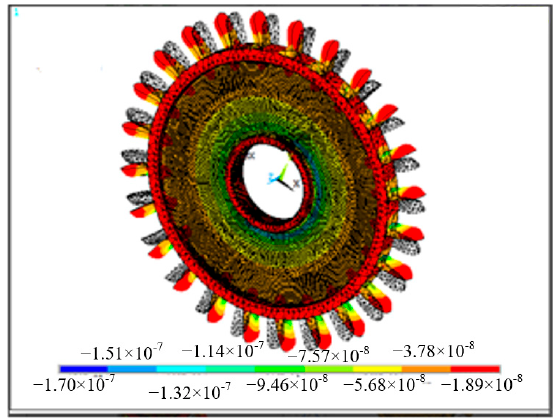
Figure 14. The strain of the water wheel.